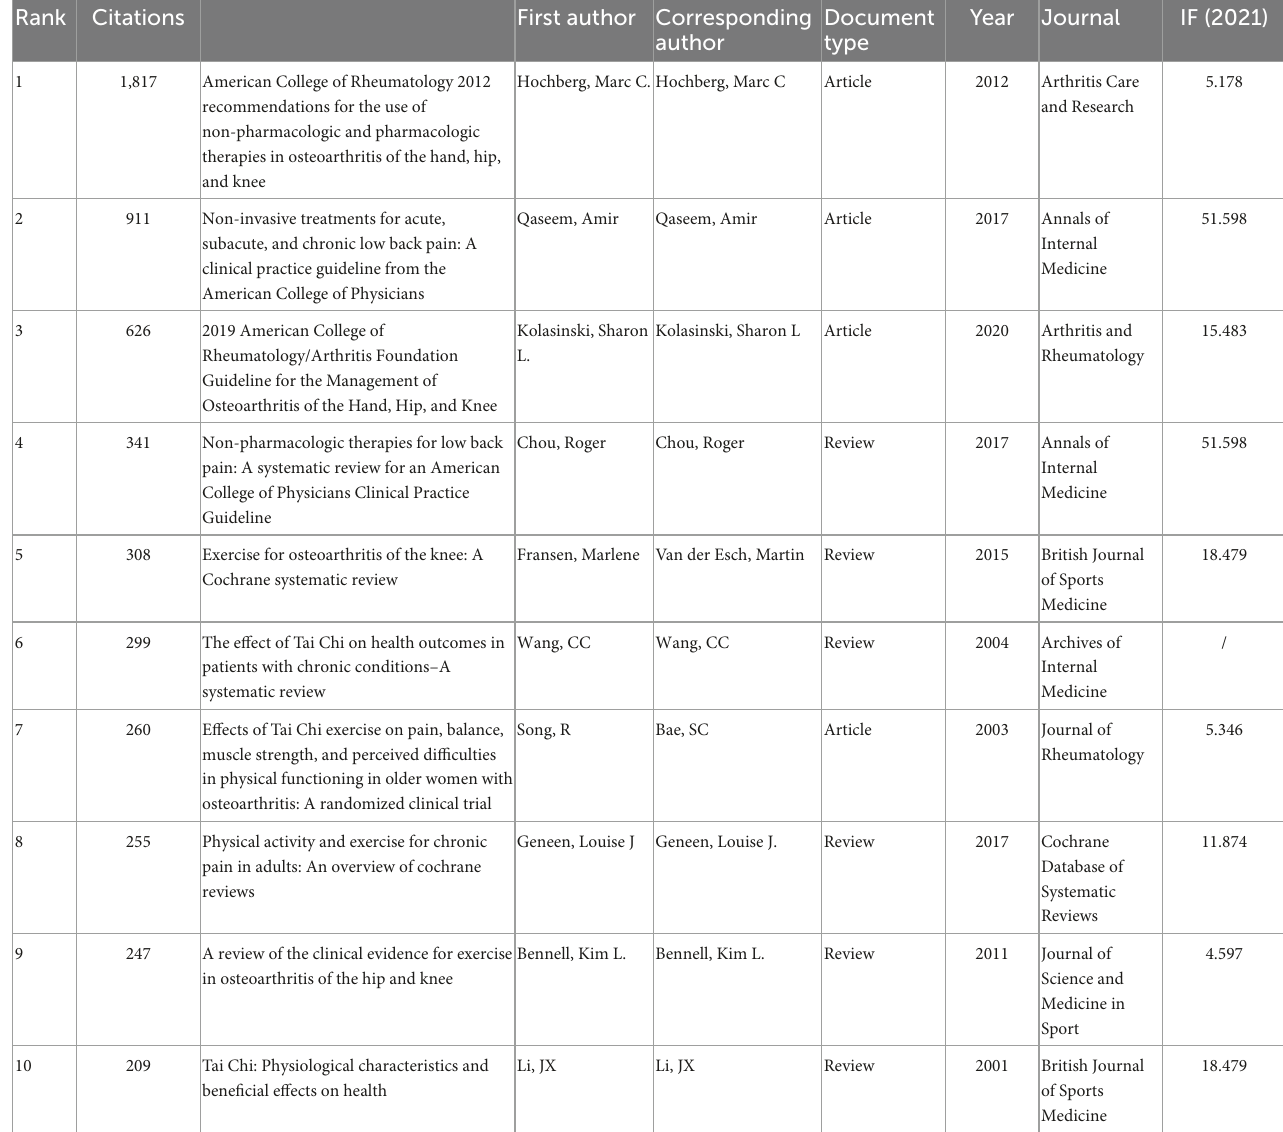
TABLE 6 The top 10 references based on the number of citations traditional Chinese exercises for musculoskeletal